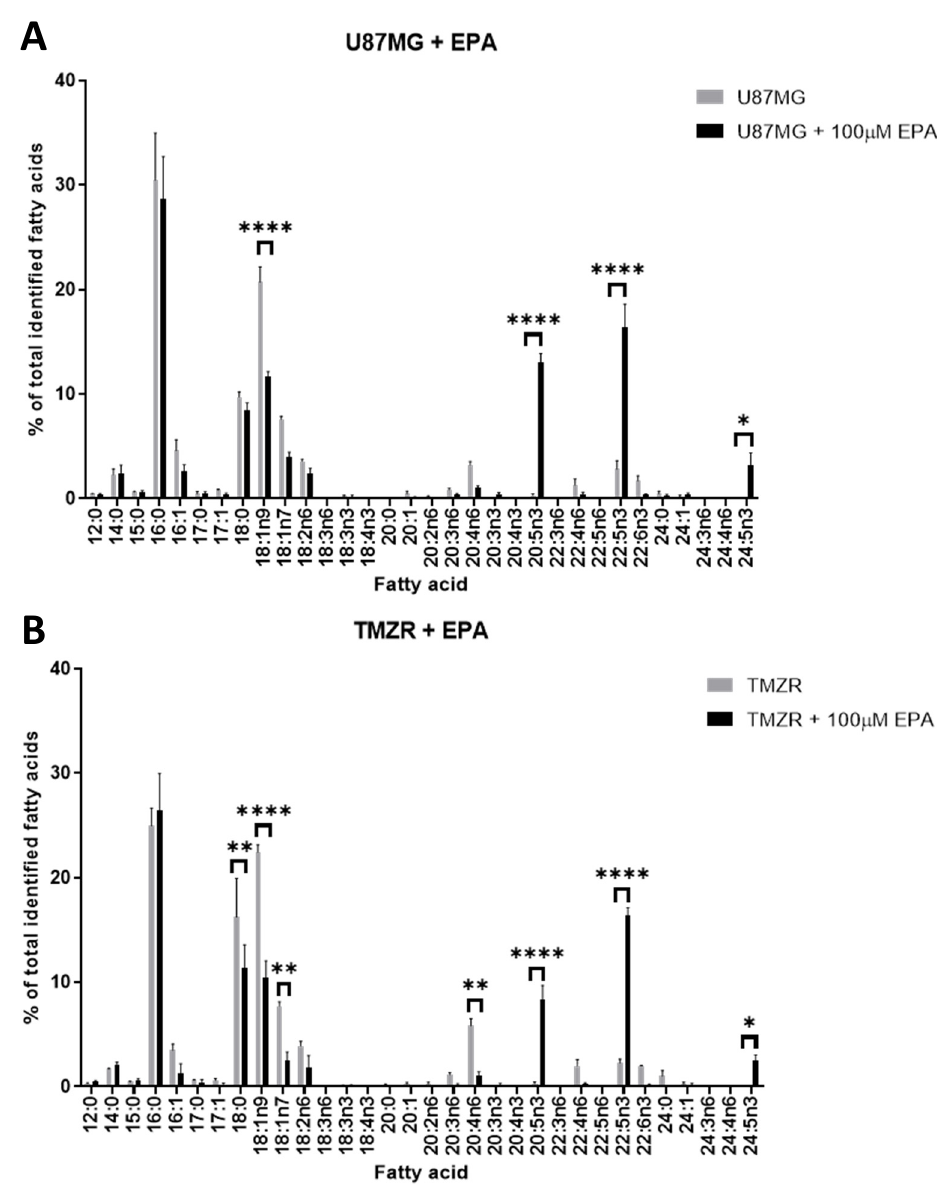
Figure 6. Effects of eicosapentaenoic acid (EPA) on fatty acid composition of U87MG and TMZR cells ( A ) U87MG cells ( B ) TMZR cells. Data are presented as mean ± SEM, N = 3. Differences were considered significant at p < 0.05. * = p < 0.05; ** = p < 0.01; **** = p < 0.0001.